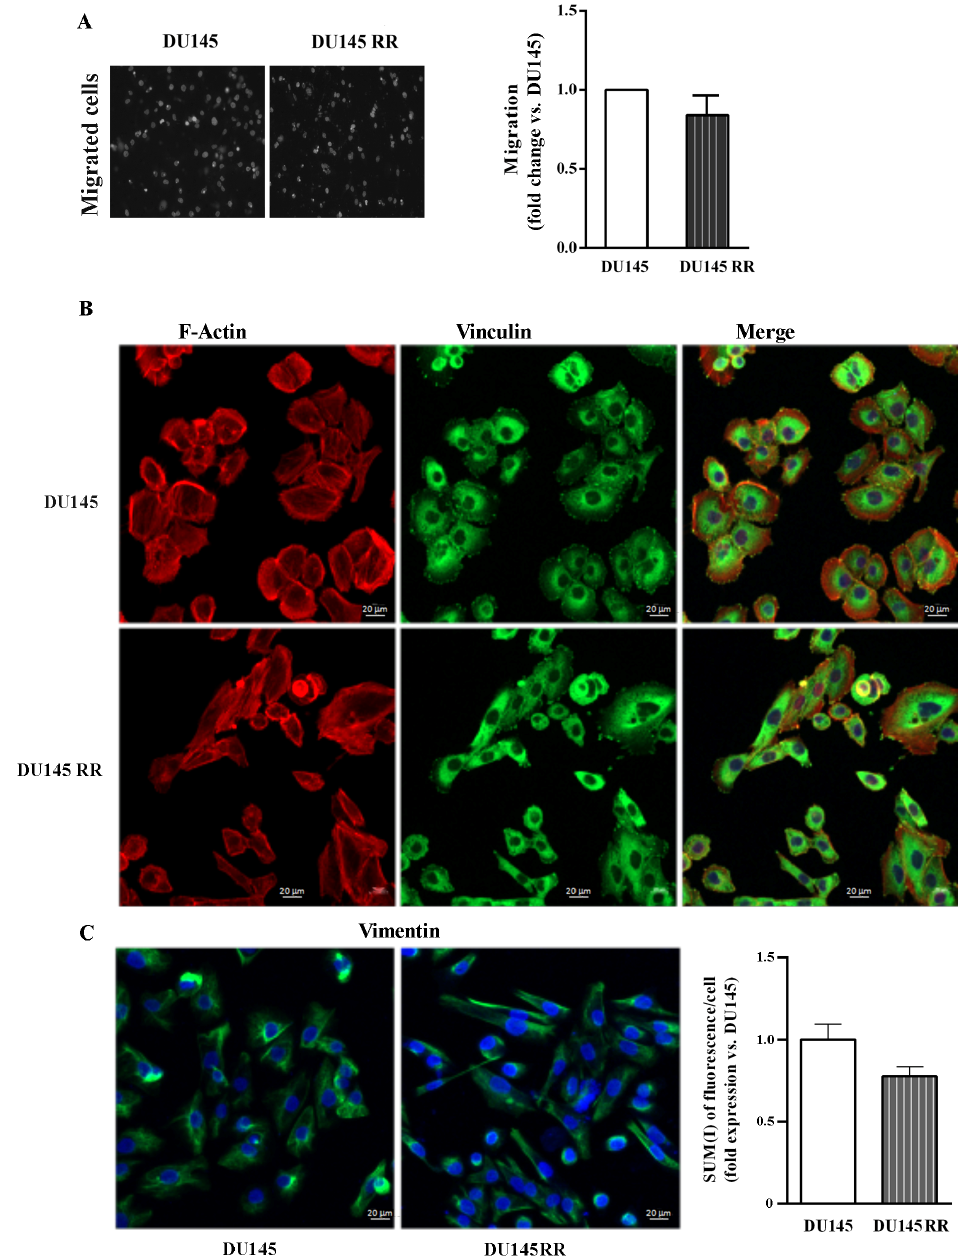
Figure 7. Migration capability and cytoskeleton organization of parental DU-145 and DU-145RR. ( A ) Representative images of trans-well migration 24 h after plating of DAPI-labeled DU-145 and DU-145RR cells (left). Data are expressed as the fold increase of migration rate relative to DU-145 cells (set arbitrarily at one) (right). ( B ) Representative confocal micrographs showing distribution of F-Actin in red (Rhodamine phalloidin), vinculin in green (FITC) and nuclei in blue (TOPRO-3) (scale bar 20 µm). ( C ) Representative confocal micrographs showing staining of vimentin in green (FITC) and nuclei in blue (TOPRO-3) (scale bar 20 µm). Graph indicates fluorescence intensity of vimentin; (SUM(I)/cell) performed using Zeiss software. Data are expressed as the mean ± S.E.M. derived from at least three independent experiments. Statistical significance DU-145RR vs. DU-145 Student’s unpaired t